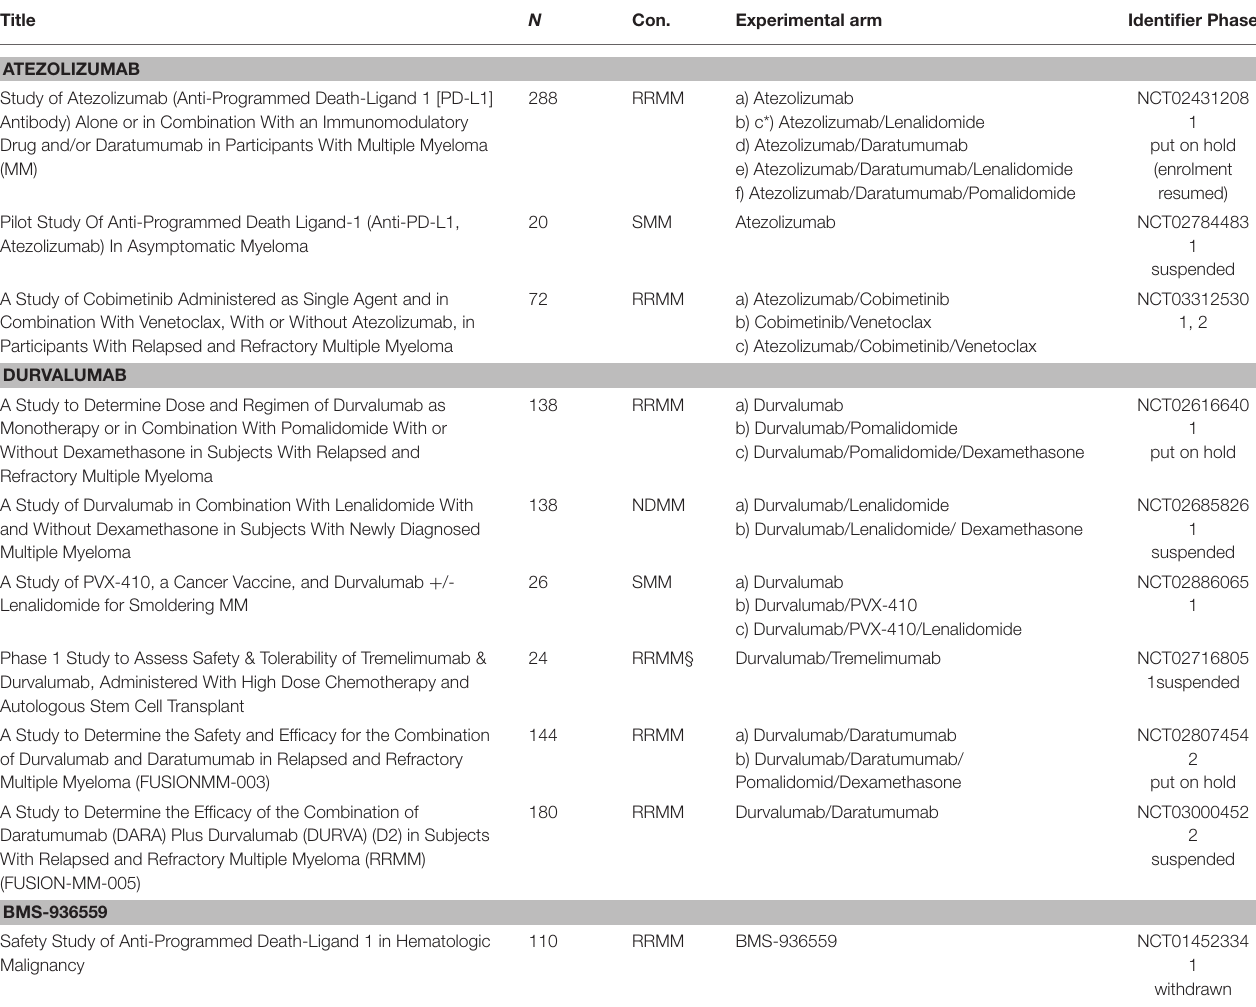
TABLE 4 | Ongoing clinical trials with PD-L1 inhibitors in multiple myeloma (Atezolizumab, Durvalumab,